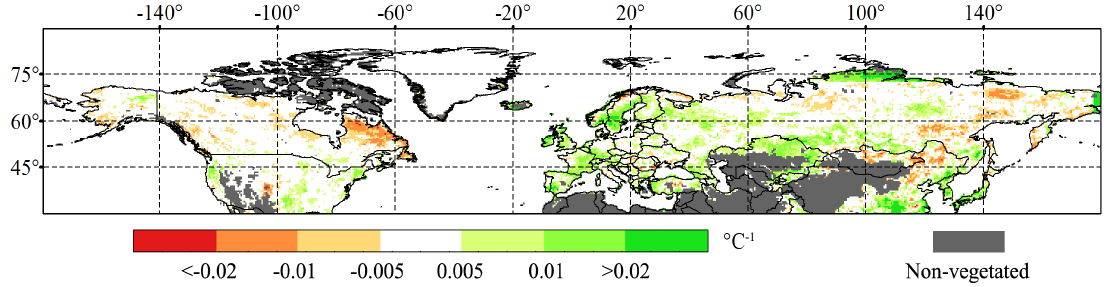
Figure 10. Differences between NDVI3g and NDVIg in the response of growing-season NDVI to temperature change during